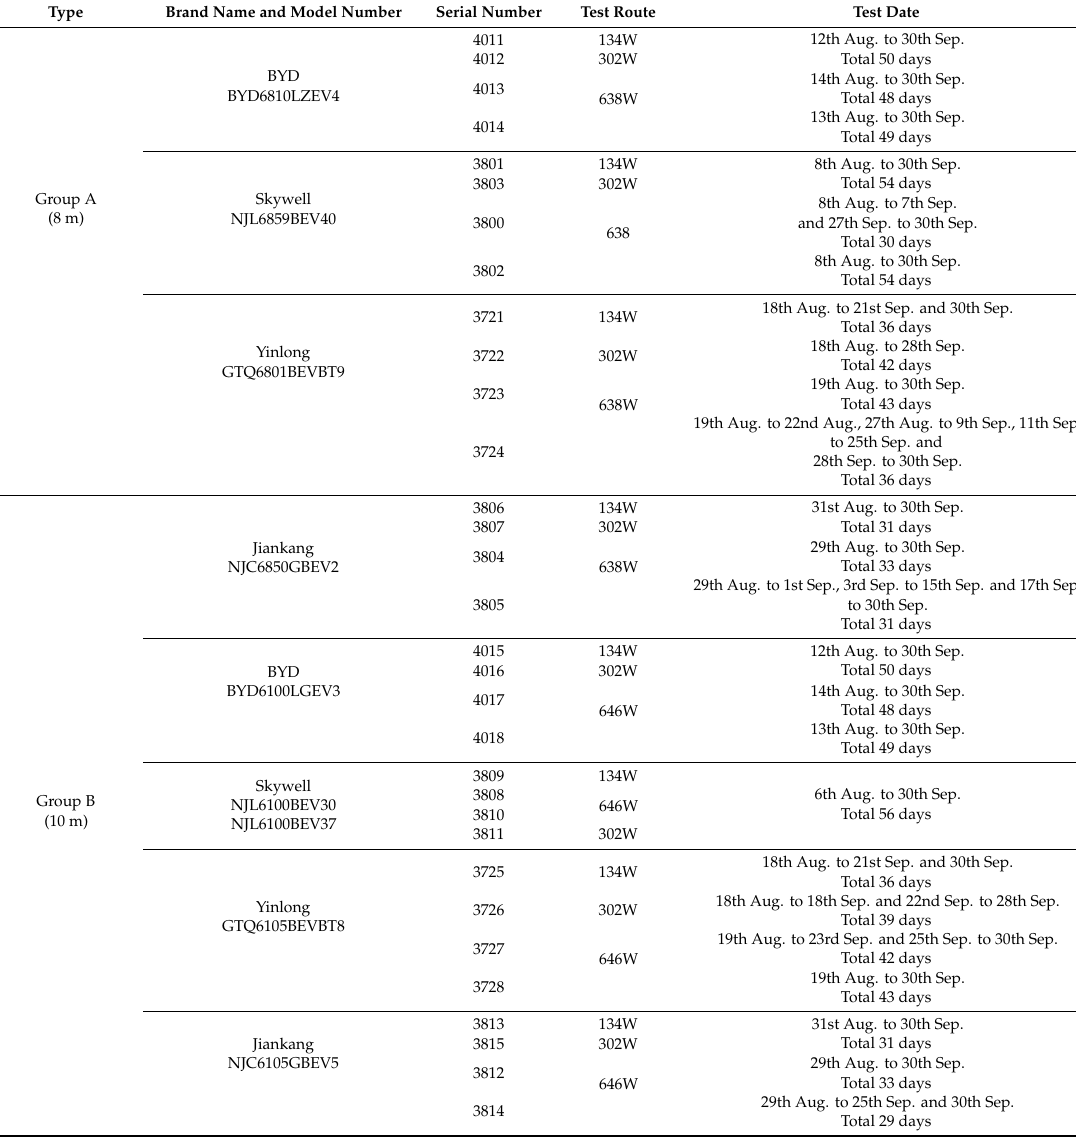
Table 3. Operation